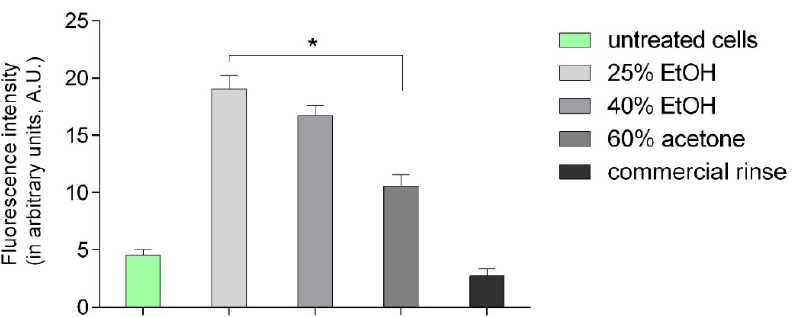
Figure 3. Intensity of fluorescence of histone H3 after 24 h incubation with different extracts of Reynoutria japonica in fibroblasts in arbitrary units. Error bars shown in this figure are means ± SD for n ≥ 5. * statistically significant at p < 0.0001.